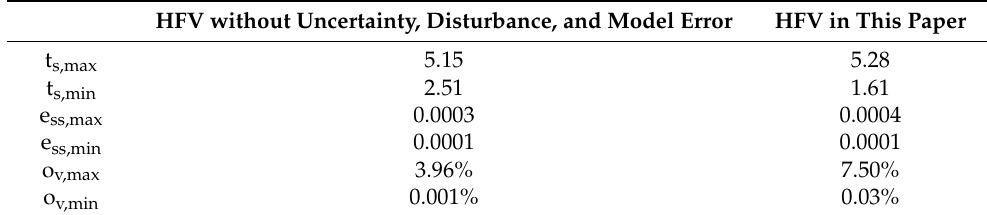
Table 4. Comparative analysis II of performance indicators between ideal and harsh models. HFV without Uncertainty, Disturbance, and Model Error